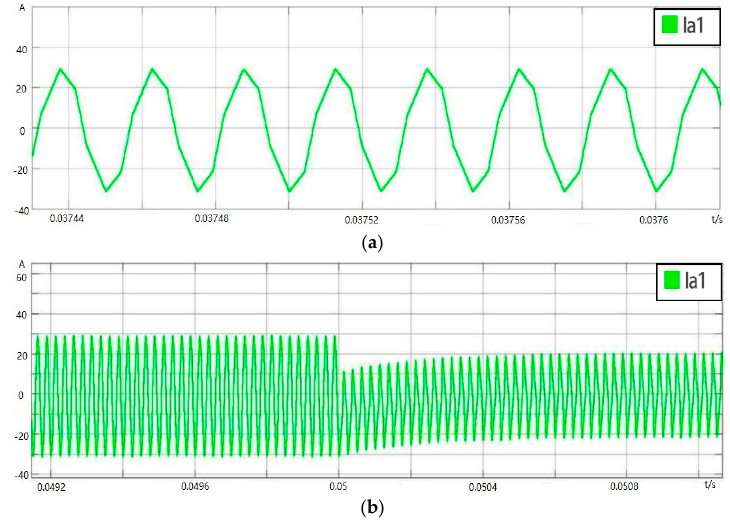
Figure 15. Inductance current waveforms on ( a ) Steady state; ( b ) transient state.